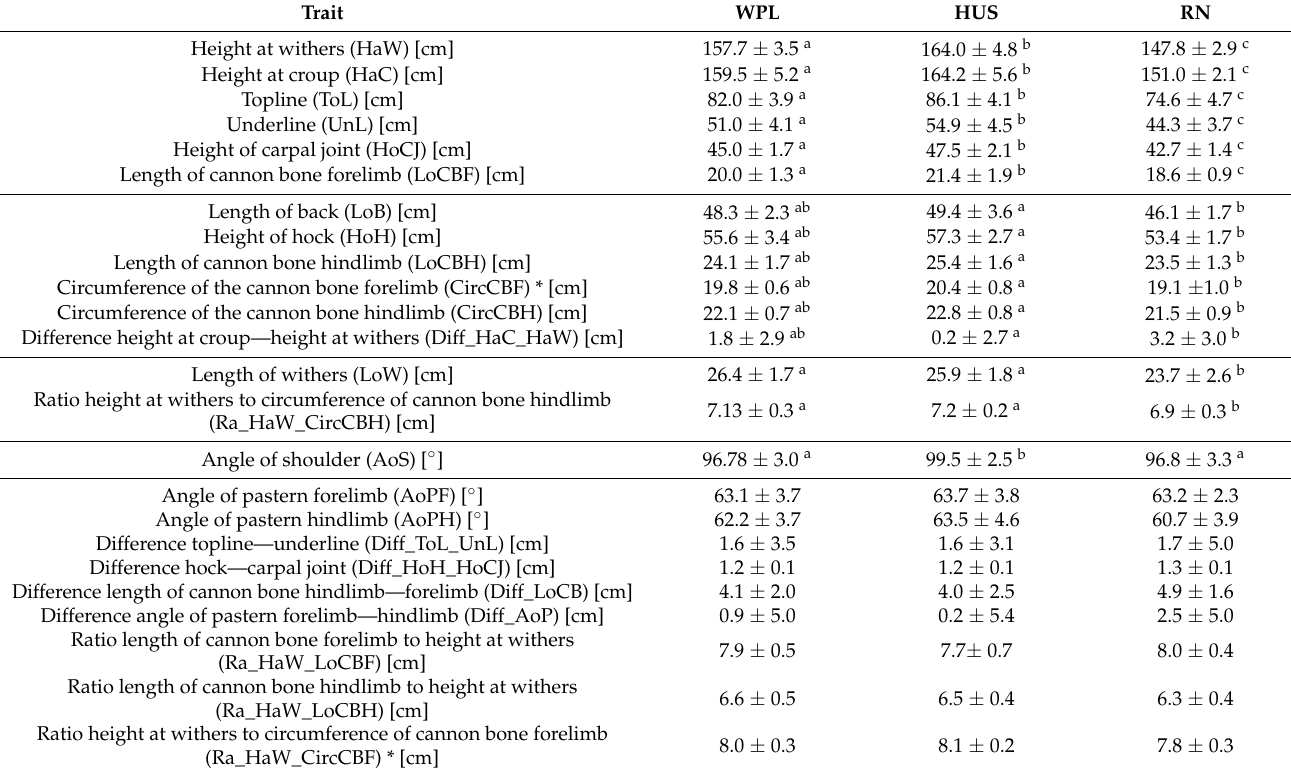
Table 3. Comparison by means using the ANOVA model including post hoc analysis and Bonferroni correction (level of significance p < 0.05; means ± standard